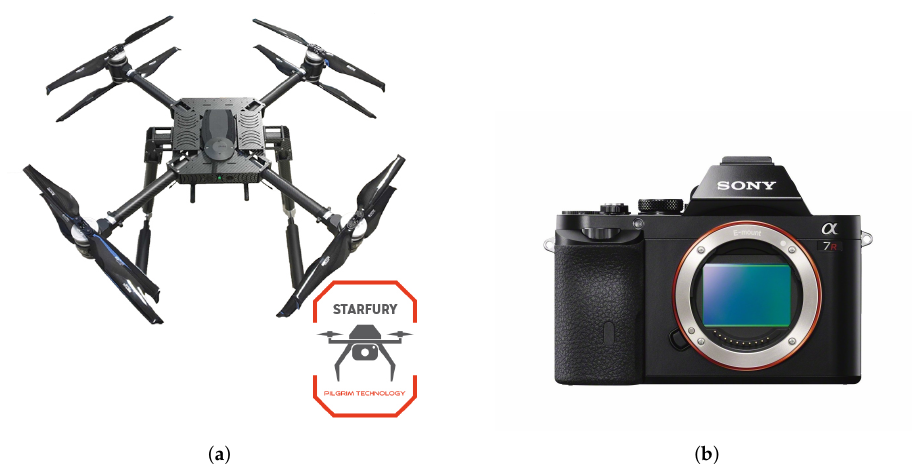
Figure 1. Apparatus used for data acquisition. ( a ) Starfury Drone; ( b ) Sony ILCE-7R Camera.